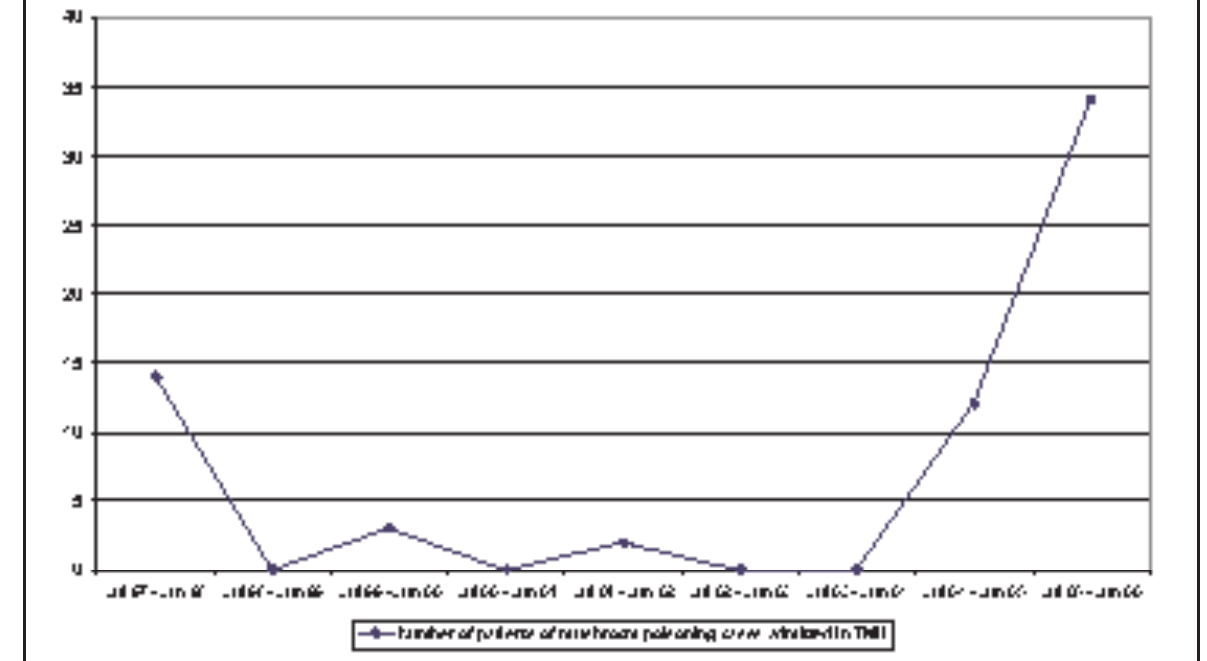
Fig.1: Number of Mushroom poisoning cases admitted in TMH in last 10 years (Source: Hospital